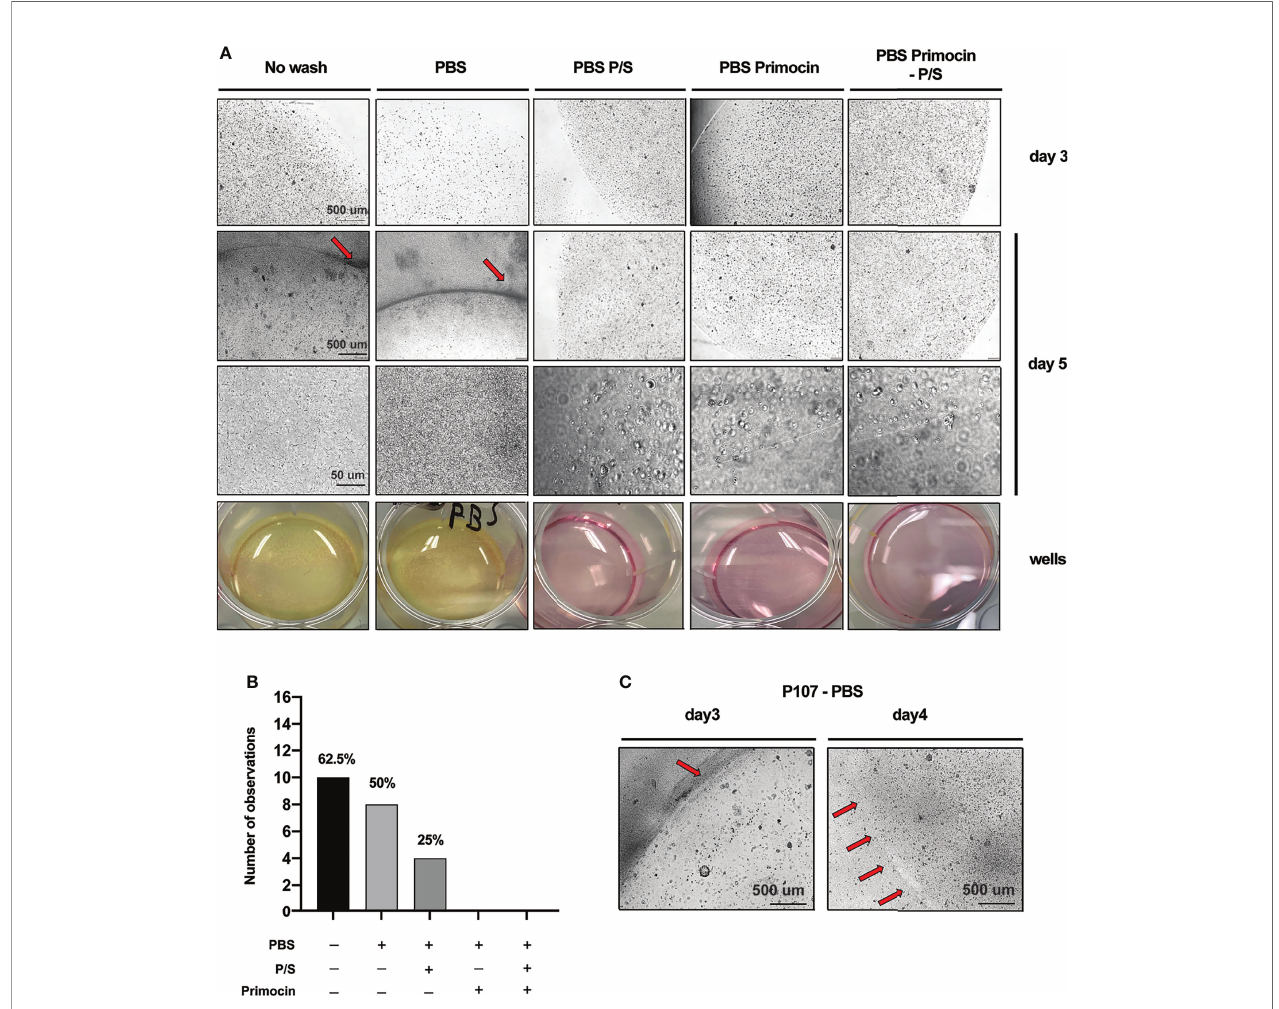
FIGURE 3 | Primocin-containing washing solutions protect from bacteria contamination during organoids derivation from colorectal cancer patients. (A) Representative micrograph of P115 PDO cultures acquired at the microscope at day 3 and day 5. The fi rst 2 micrographs acquired at day 5 refer to the contaminated PDO cultures and the darker area indicated by the red arrow indicates areas with high concentration of bacteria. The yellow color of the medium indicates high metabolic activity in the well due to bacteria proliferation. At high magni fi cation, it is possible to appreciate the shape of chain-forming bacilli. (B) Total events observed for each washing condition. The numbers on top of the bars indicate the percentage of contaminated samples while the bars represent the absolute number of observed contaminations for each condition (within a total of 16). (C) Matrigel drop degradation due to bacterial contamination in P107 PDO culture. Red arrows at day 4 indicate the residue of Matrigel drop borders left after degradation, while the higher black background indicates a diffusion of